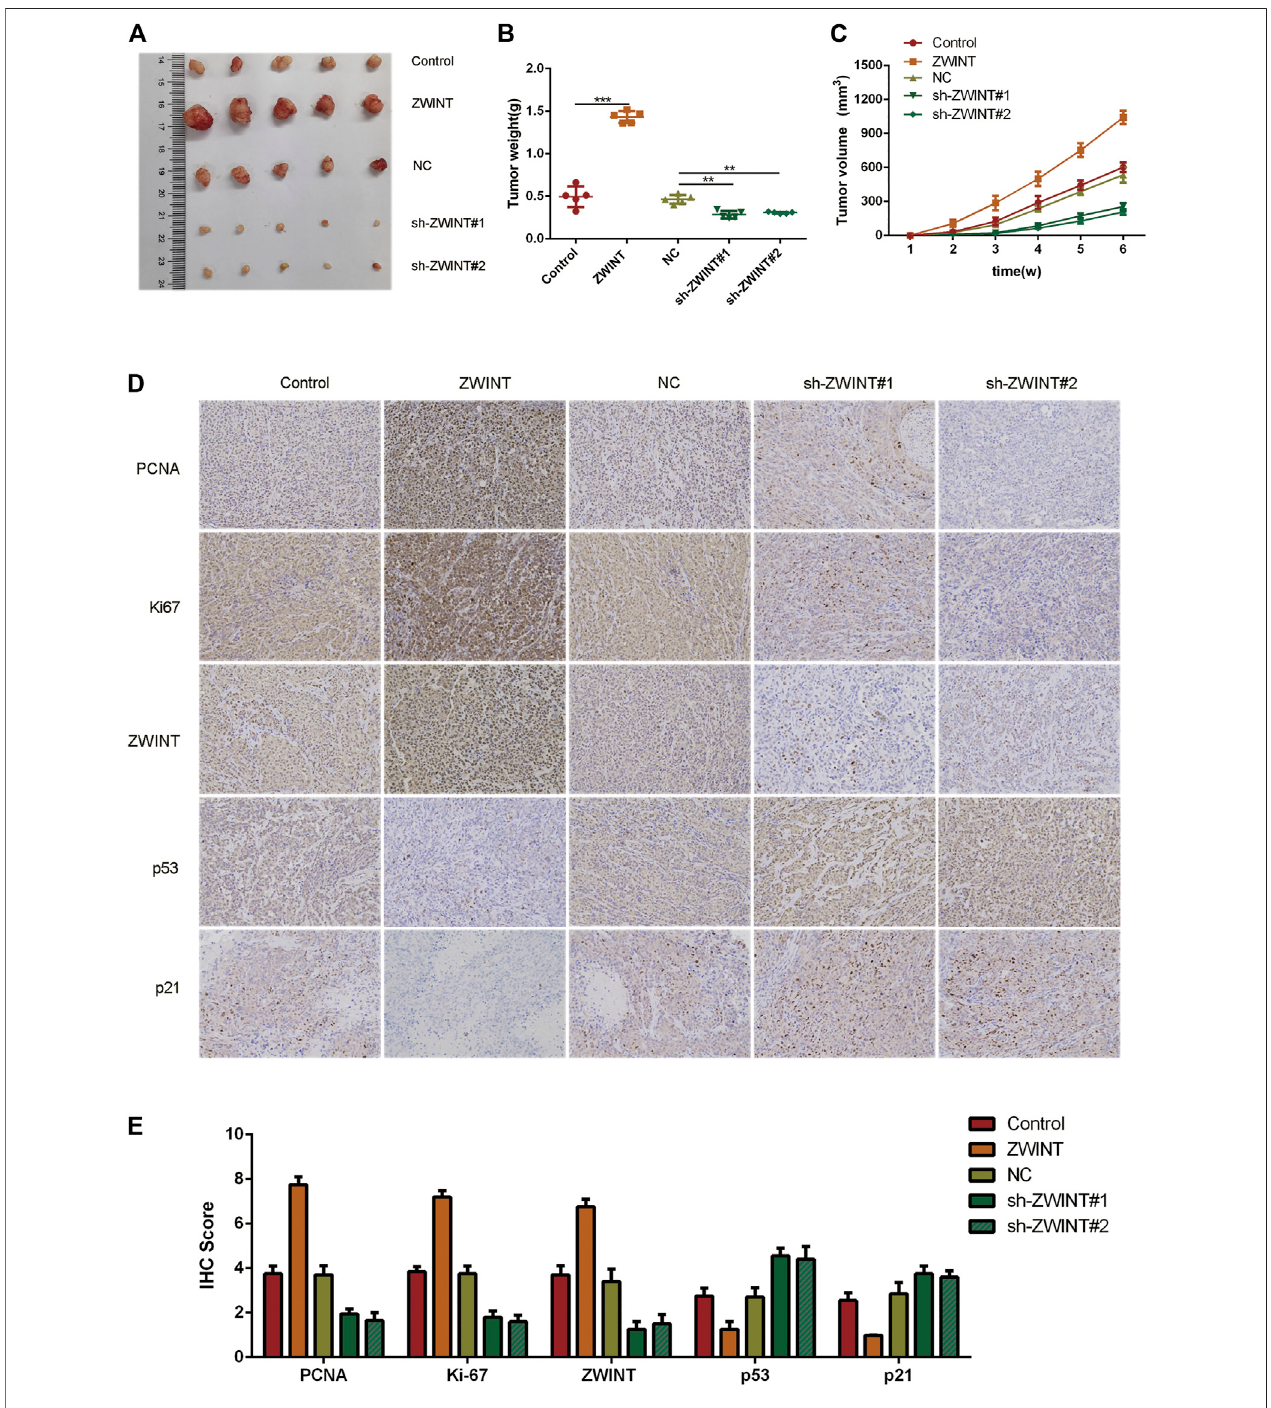
FIGURE7| ZWINTpromotedpancreaticcancergrowth invivo .aRepresentpicturesoftumorformationofxenograftofPANC-1 (A) cellsinnudemice( n (cid:2) 5). (B,C) Weight and volume of tumors in the different group mice. (D – E) Representative images of KI-67 and PCNA staining of the xenograft. * p < 0.05; ** p < 0.01.